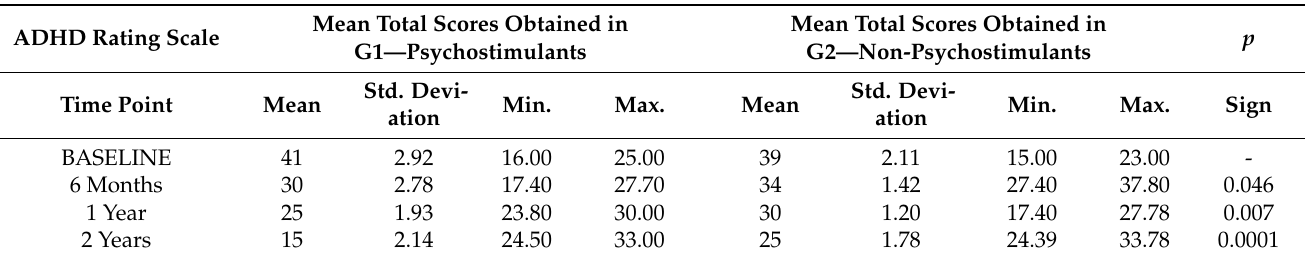
Table 3. Comparative analysis of the ADHD-RS scores between group 1 with psychostimulants and group 2 with non- psychostimulants. ADHD Rating